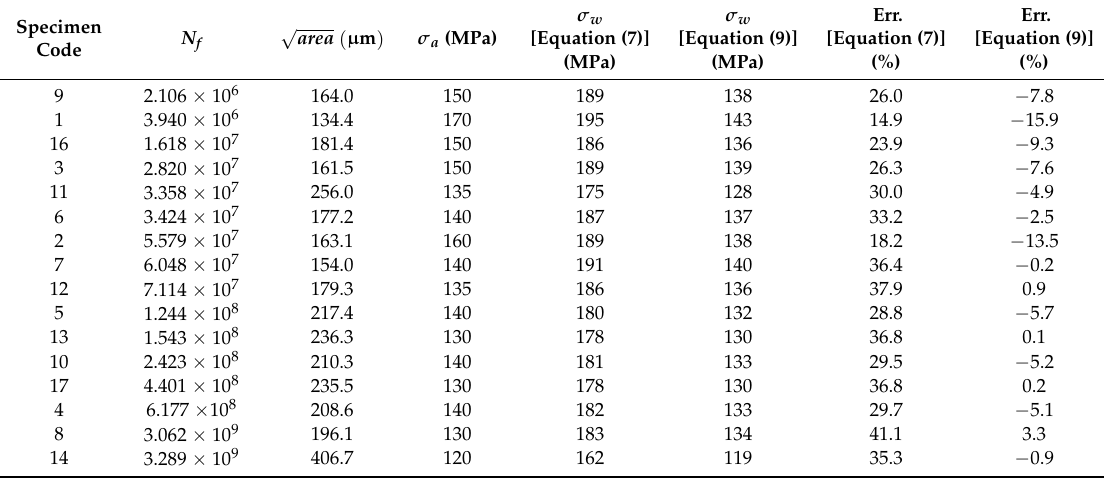
Table 3. A comparison of the estimated values of fatigue strength calculated by Equations (7) and (9) together with experimental